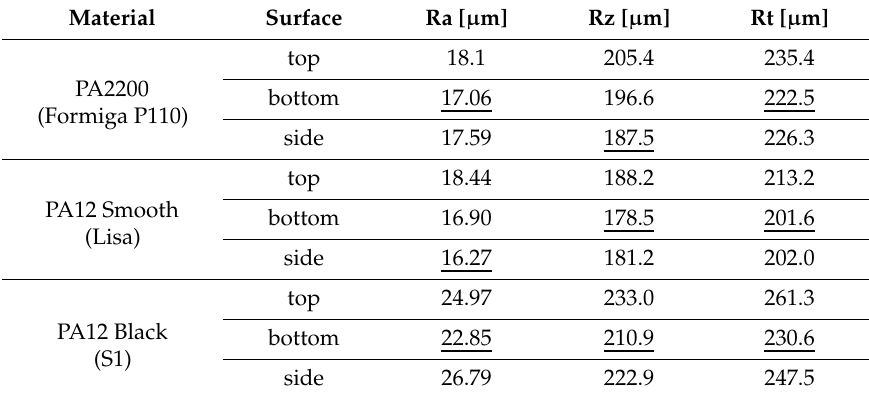
Table 6. Average Surface Roughness of the Measured